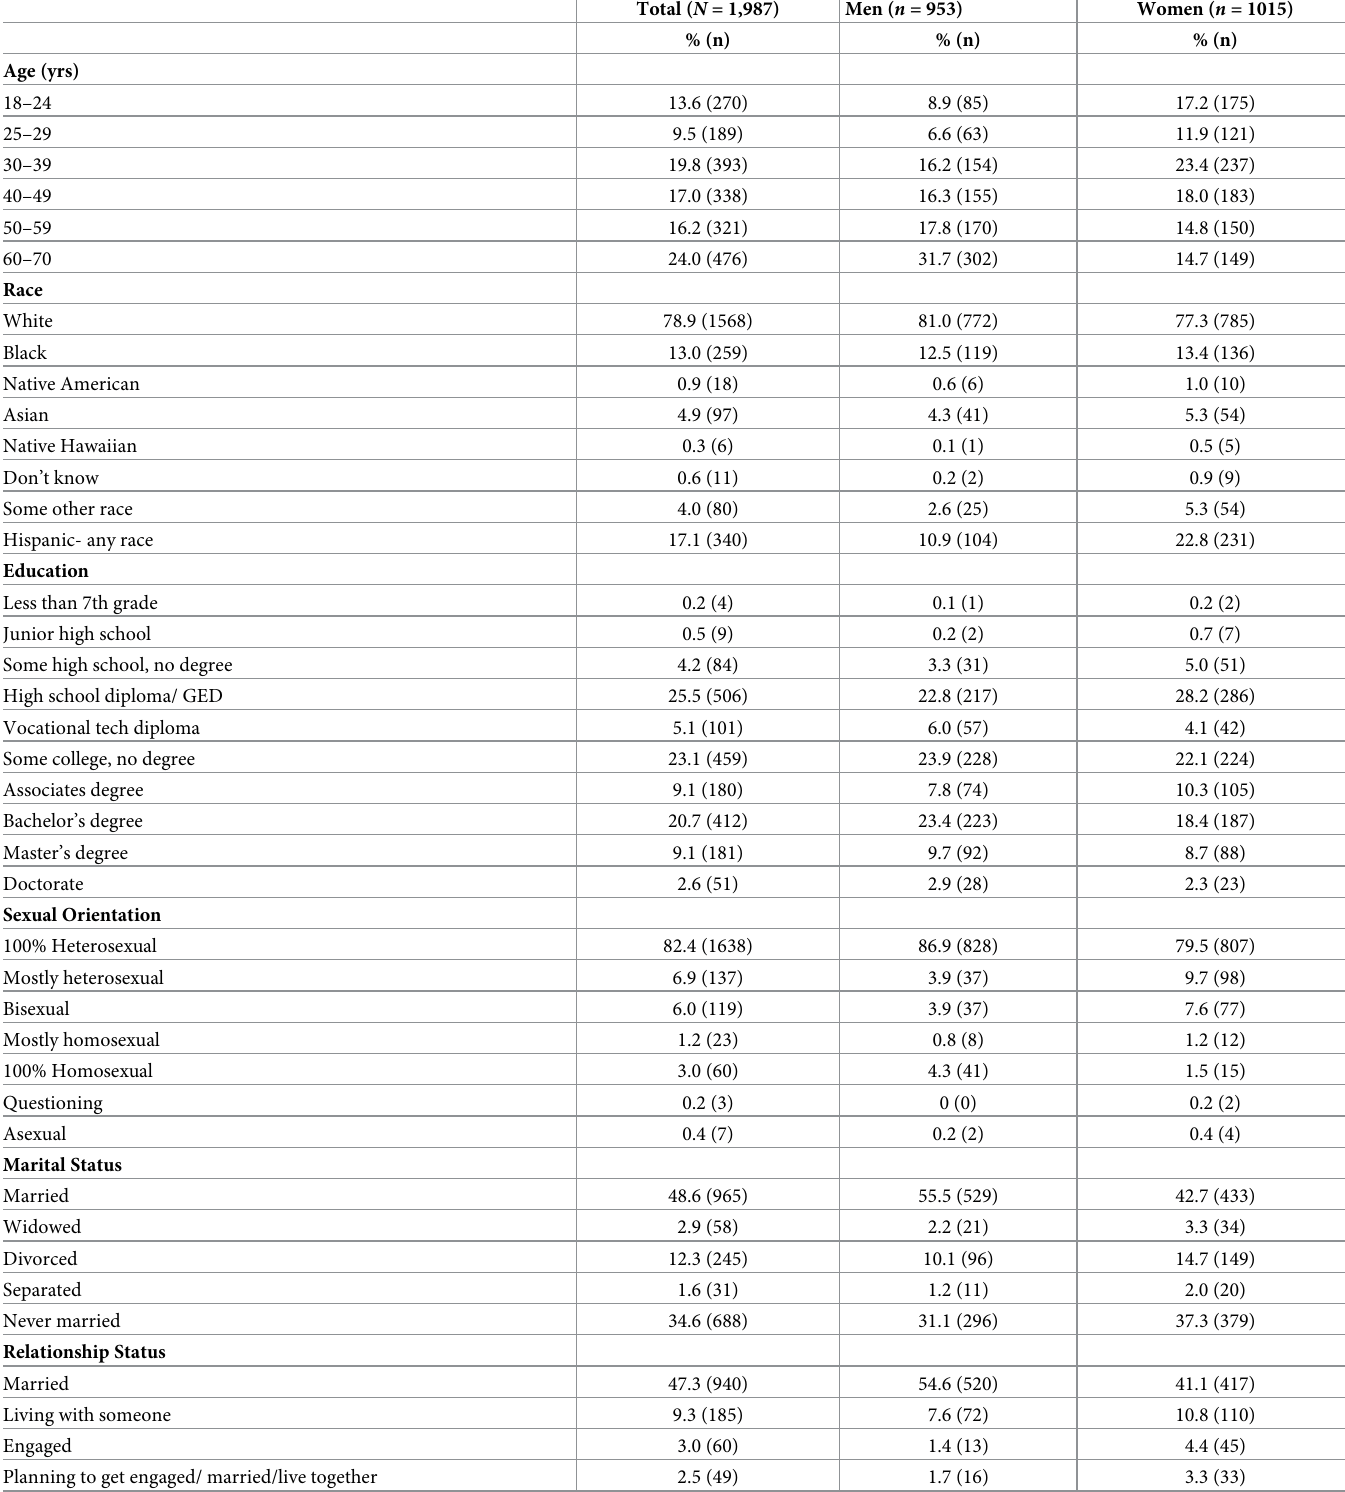
Table 1. Demographic